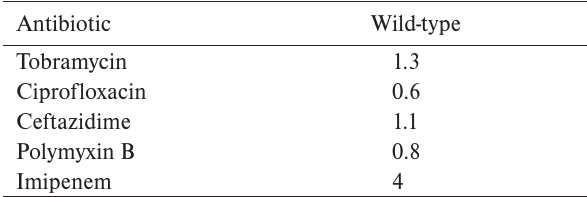
Table 1. Antibiotic resistance profile of wild-type P. aerugi- nosa PAO1 strain. MIC (μg/mL) for each antibiotic is shown. Antibiotic